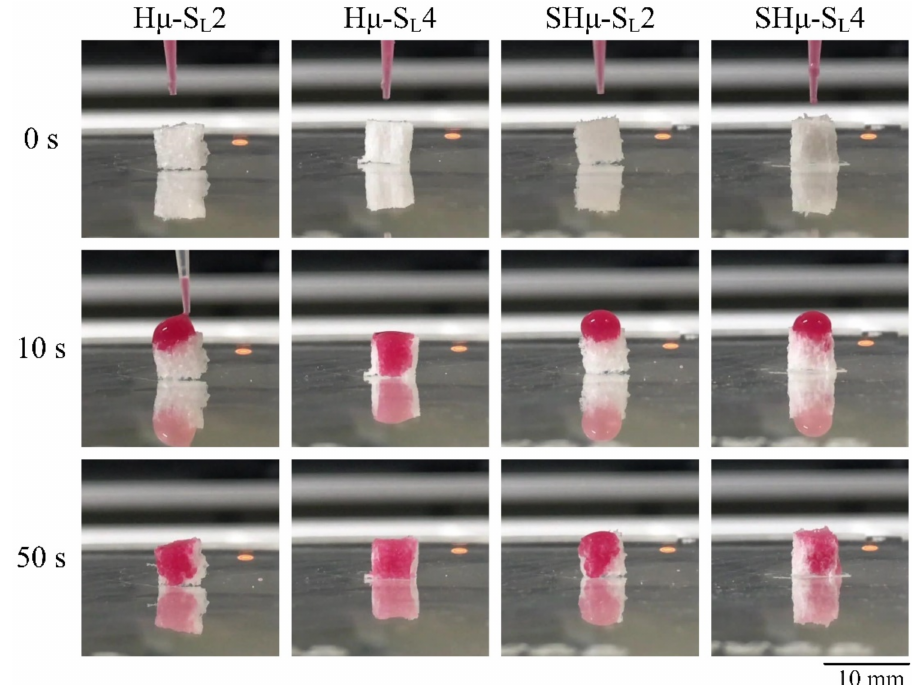
Figure 3. The water droplet staining rate was used to evaluate the distribution of interconnected pores in the hydrogel scaffold in